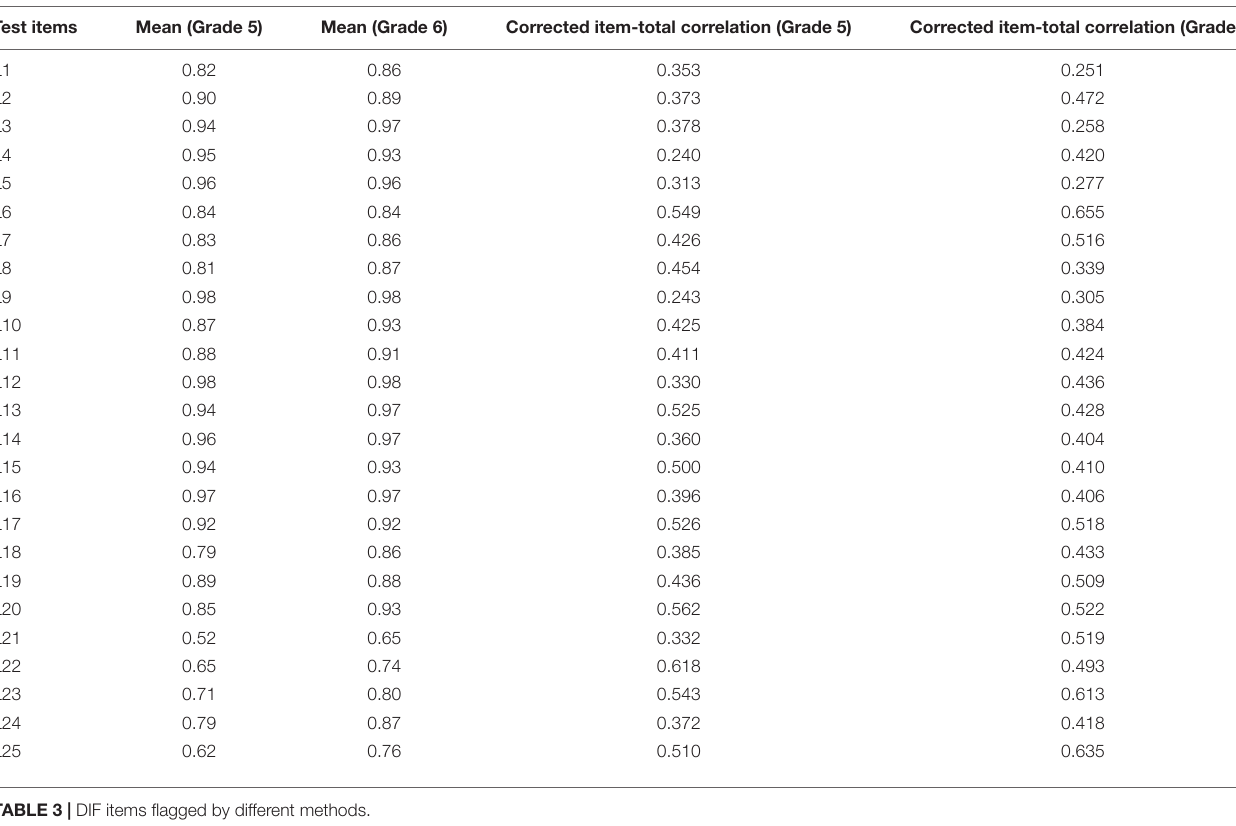
TABLE 2 | Descriptive analysis of test performance data.